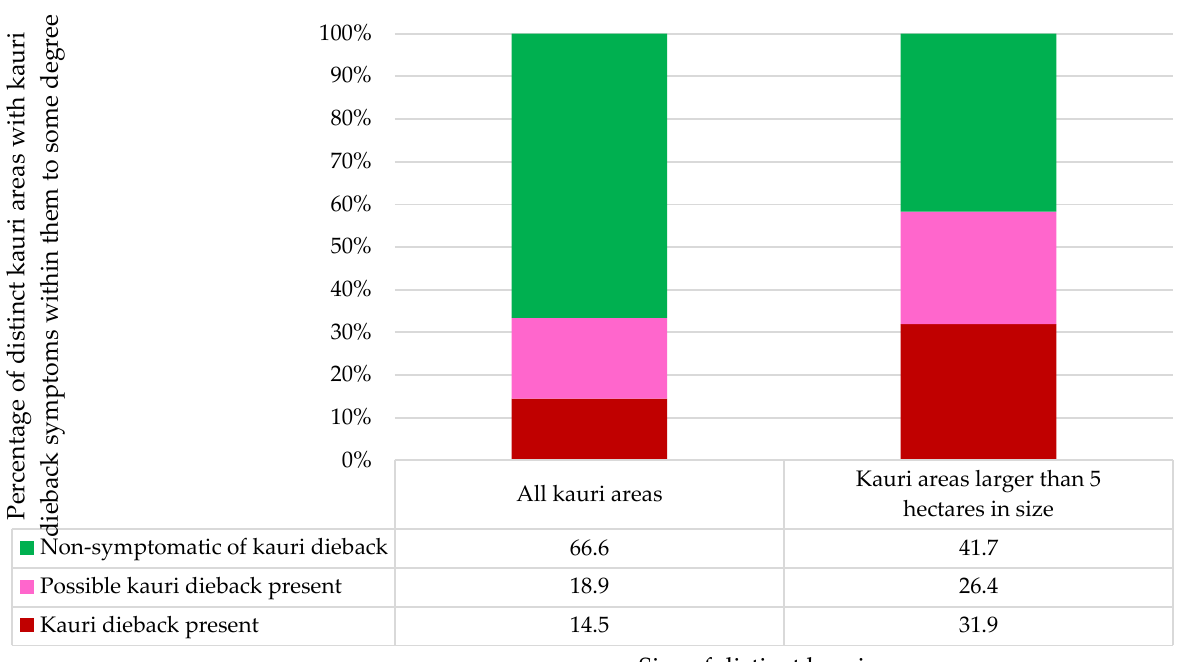
Figure 3. Presence of kauri dieback within distinct kauri areas within the WRRP highlighting that larger blocks of kauri have higher levels of kauri dieback.